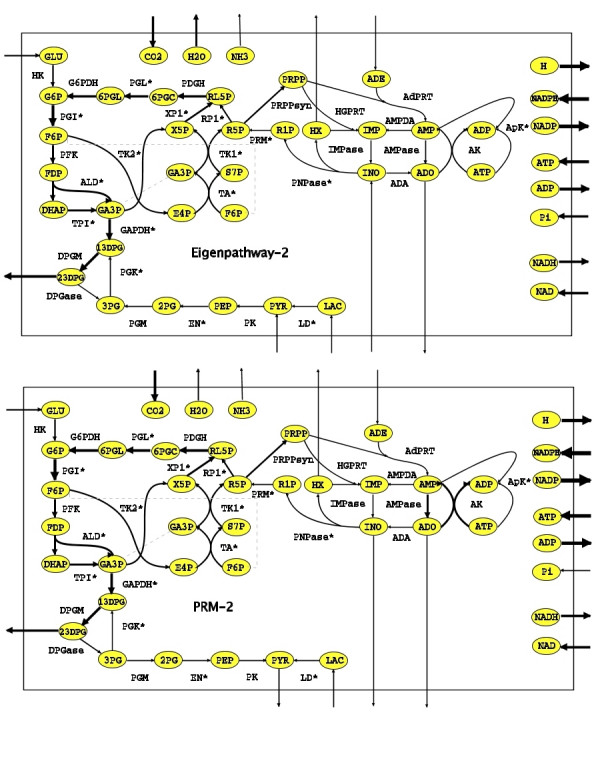
The second eigenpathway derived from SVD of the extreme pathways matrix and the second PRM derived from SVD of the samples matrix for the hRBC metabolic network. The relative values of the flux values is indicated by the thickness of the arrows between metabolites. The metabolite and reaction definitions are given in Table 1 and Table 2.